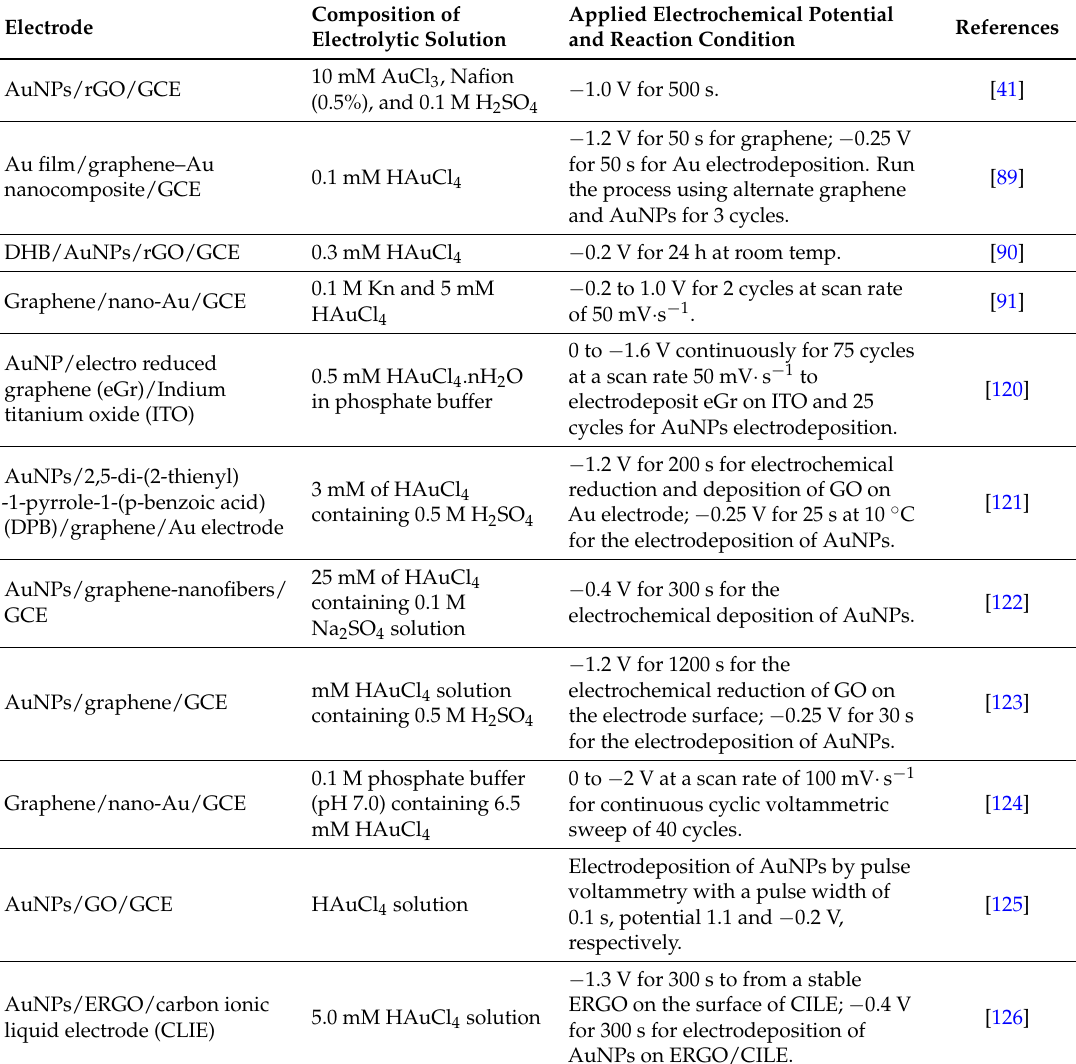
Table 5. In situ electrochemical reduction approaches for graphene–gold nanoparticles. Composition of Applied Electrochemical Potential Electrode Electrolytic Solution and Reaction